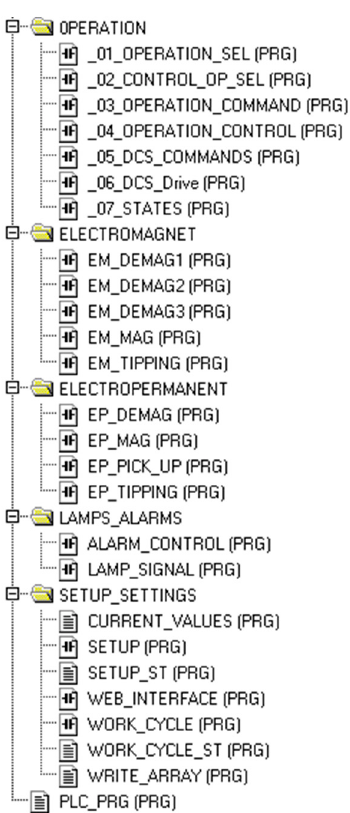
Figure 8. The sections of the PLC program.